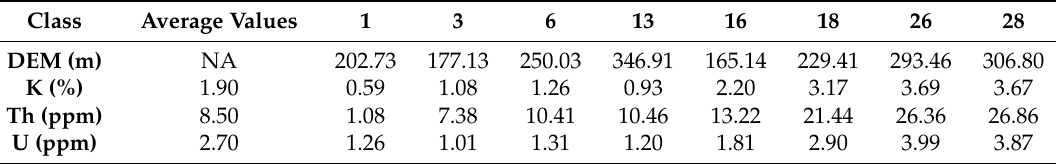
Table 3. Summary statistics for each defined class derived from input data. Average crustal abundance for radiometric elements are provided here for reference (data from Minty [61] and Rudnick and Gao